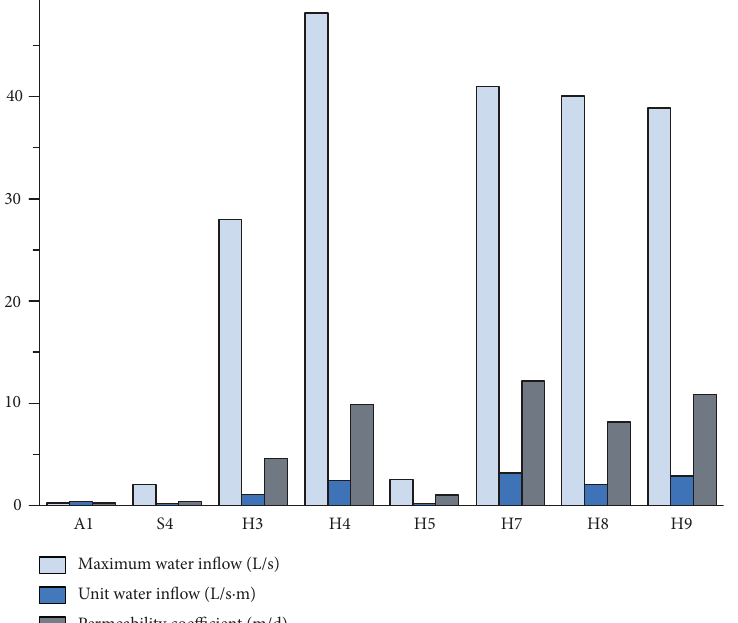
Figure 8: Results of water pumping